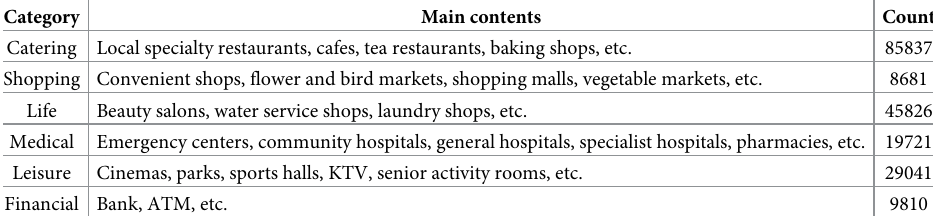
Table 1. Correspondence of basic service facility category names and main